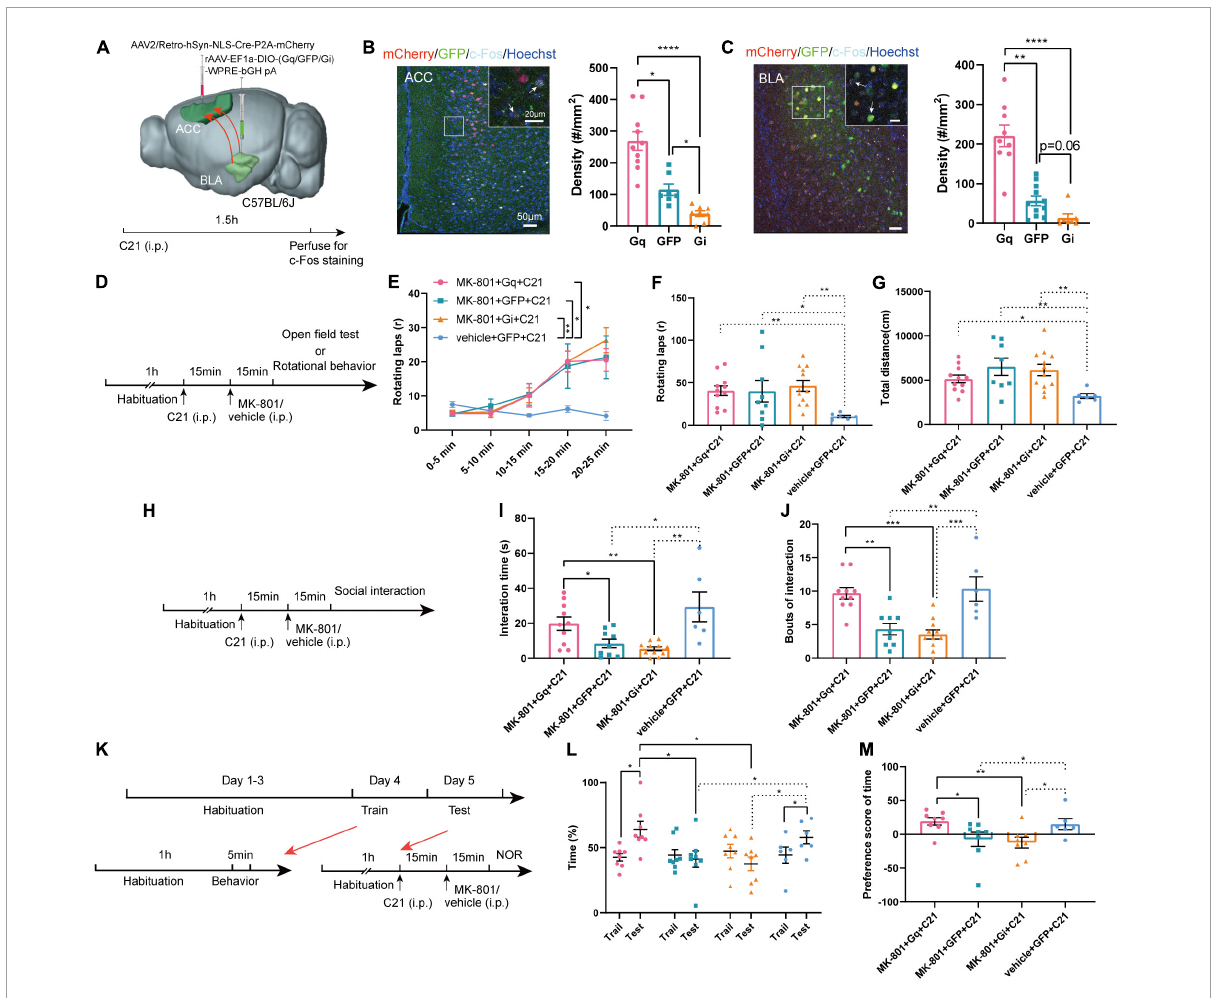
FIGURE4 Chemogenetic regulation of basolateral amygdala-anterior cingulate cortex (BLA-ACC) projecting neurons affected social and cognitive deficits but not stereotypic rotational behavior in MK-801-treated mice. (A) Schematic of the mouse brain showing that the AAV2/Retro-hSyn-NLS-Cre-P2A-mCherry virus was bilaterally injected into the ACC and the rAAV-EF1a-DIO-hM3Dq (Gq)/GFP/hM4Di (Gi)-WPRE-bGH pA viruses were bilaterally delivered into the BLA of C57BL/6J mice. (B,C) The c-Fos-positive cells in the ACC [ (C) ,